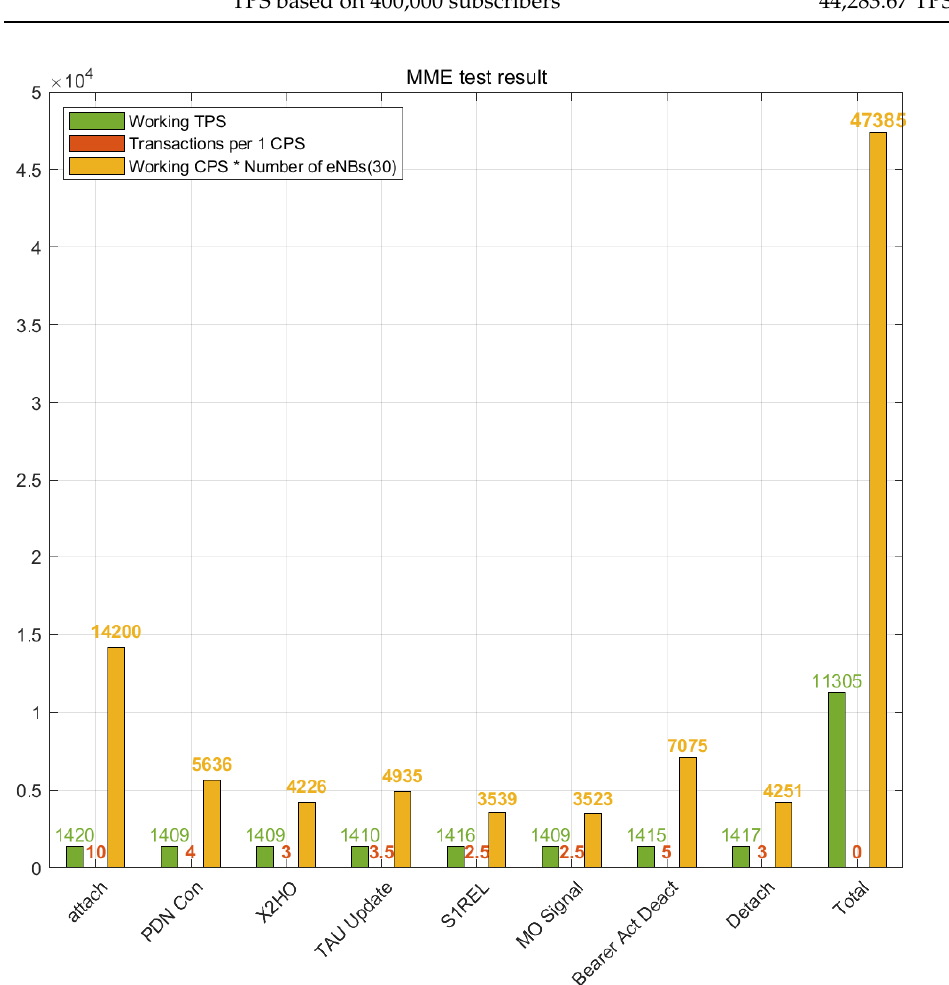
Figure 3. Test results of MME.